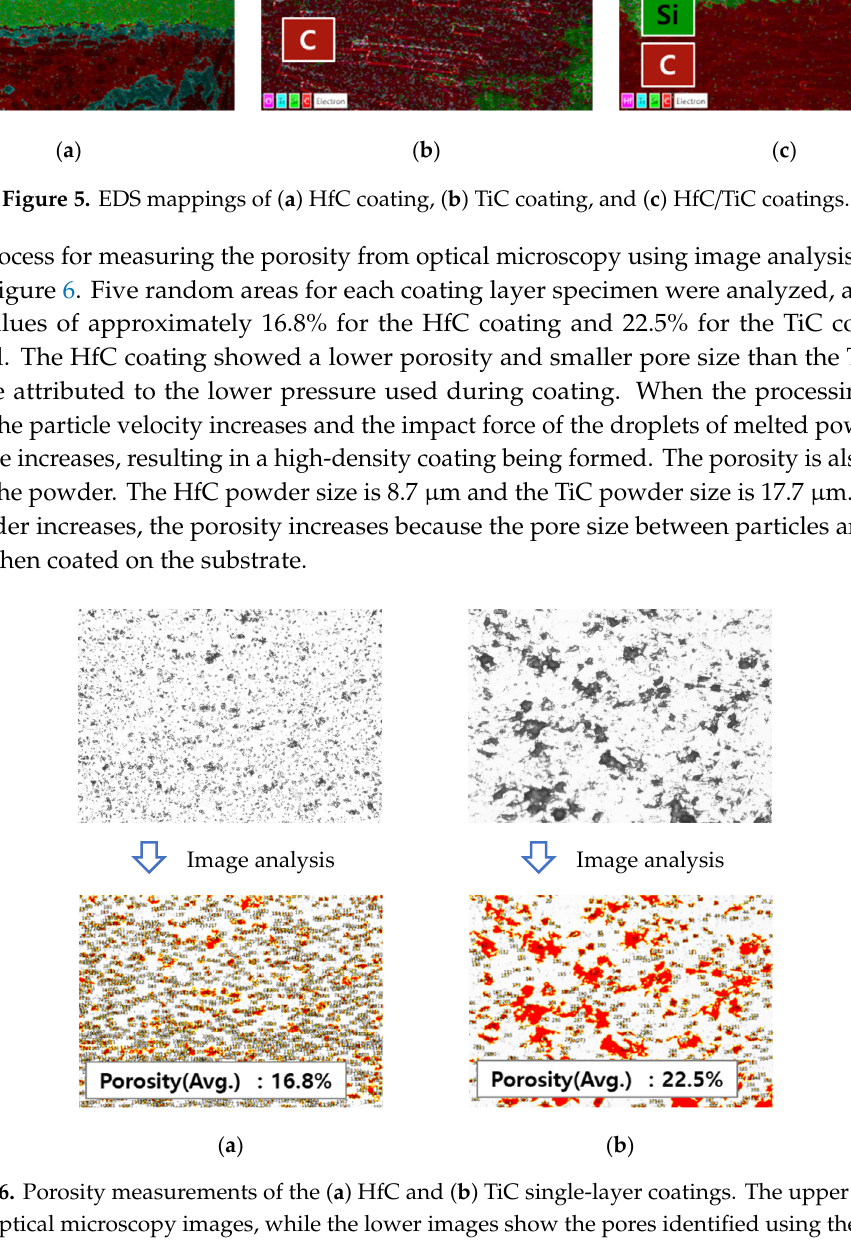
Figure 4. FE-SEM images of ( a ) HfC coating, ( b ) TiC coating, and ( c ) HfC/TiC coatings.